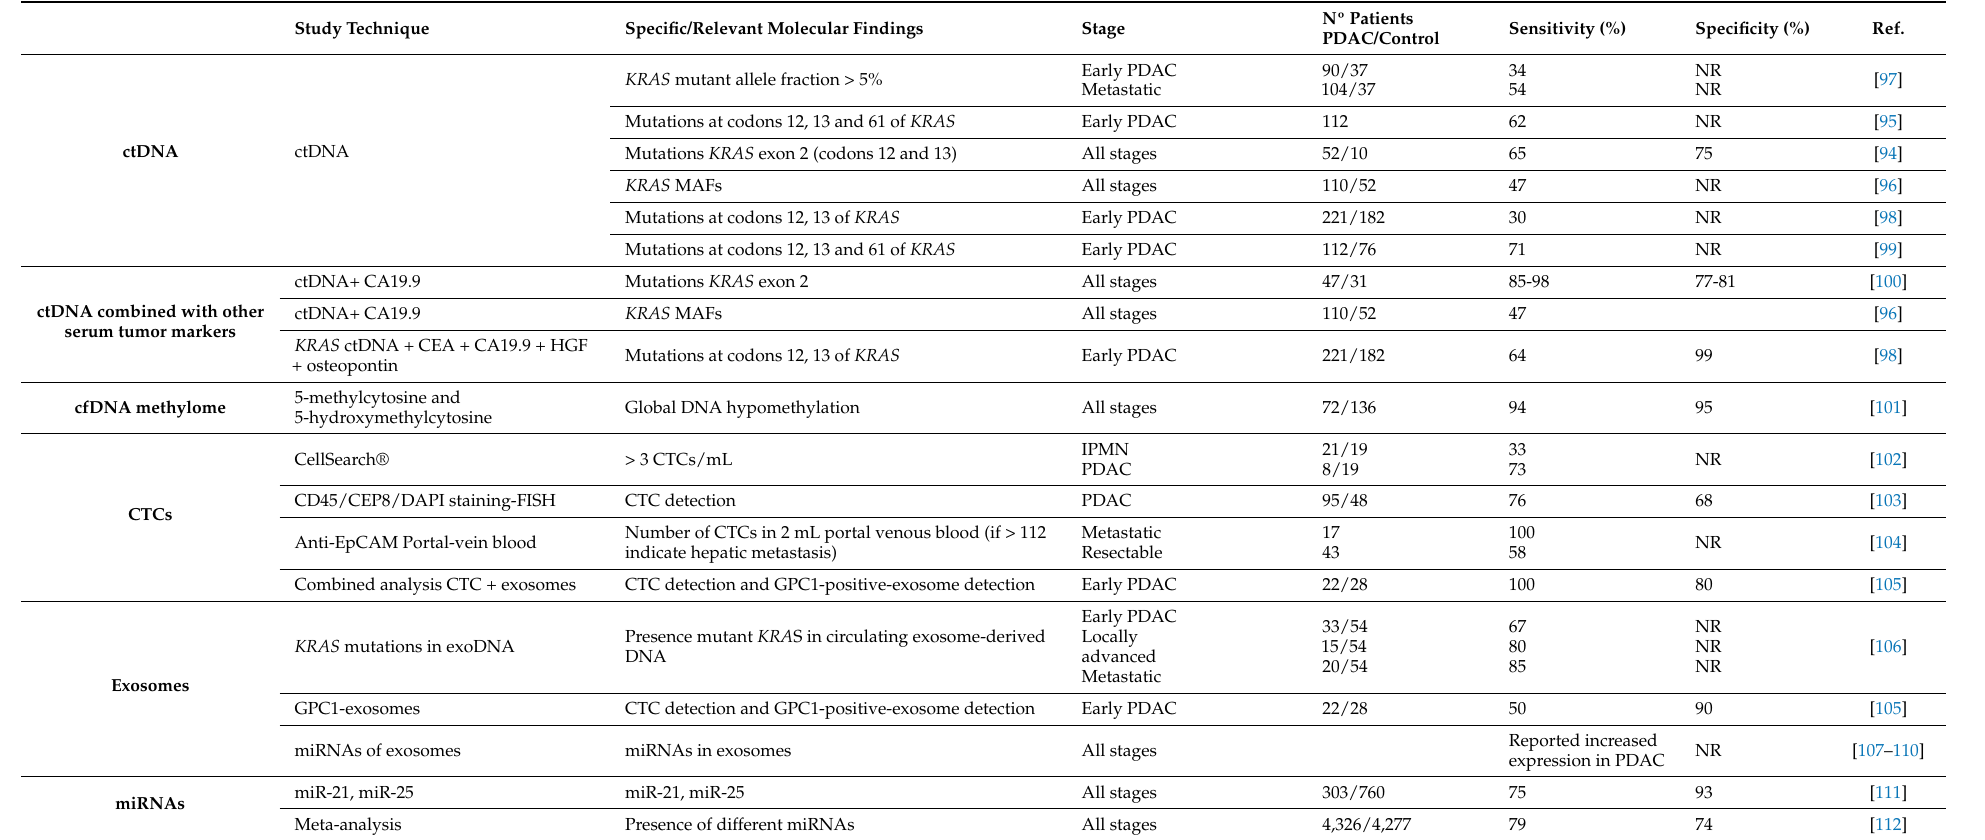
Table 2. Potential liquid-biopsy clinical usefulness in early-diagnosis of pancreatic